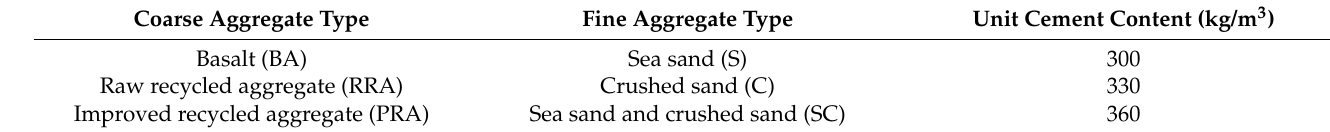
Table 1. Experimental plan.